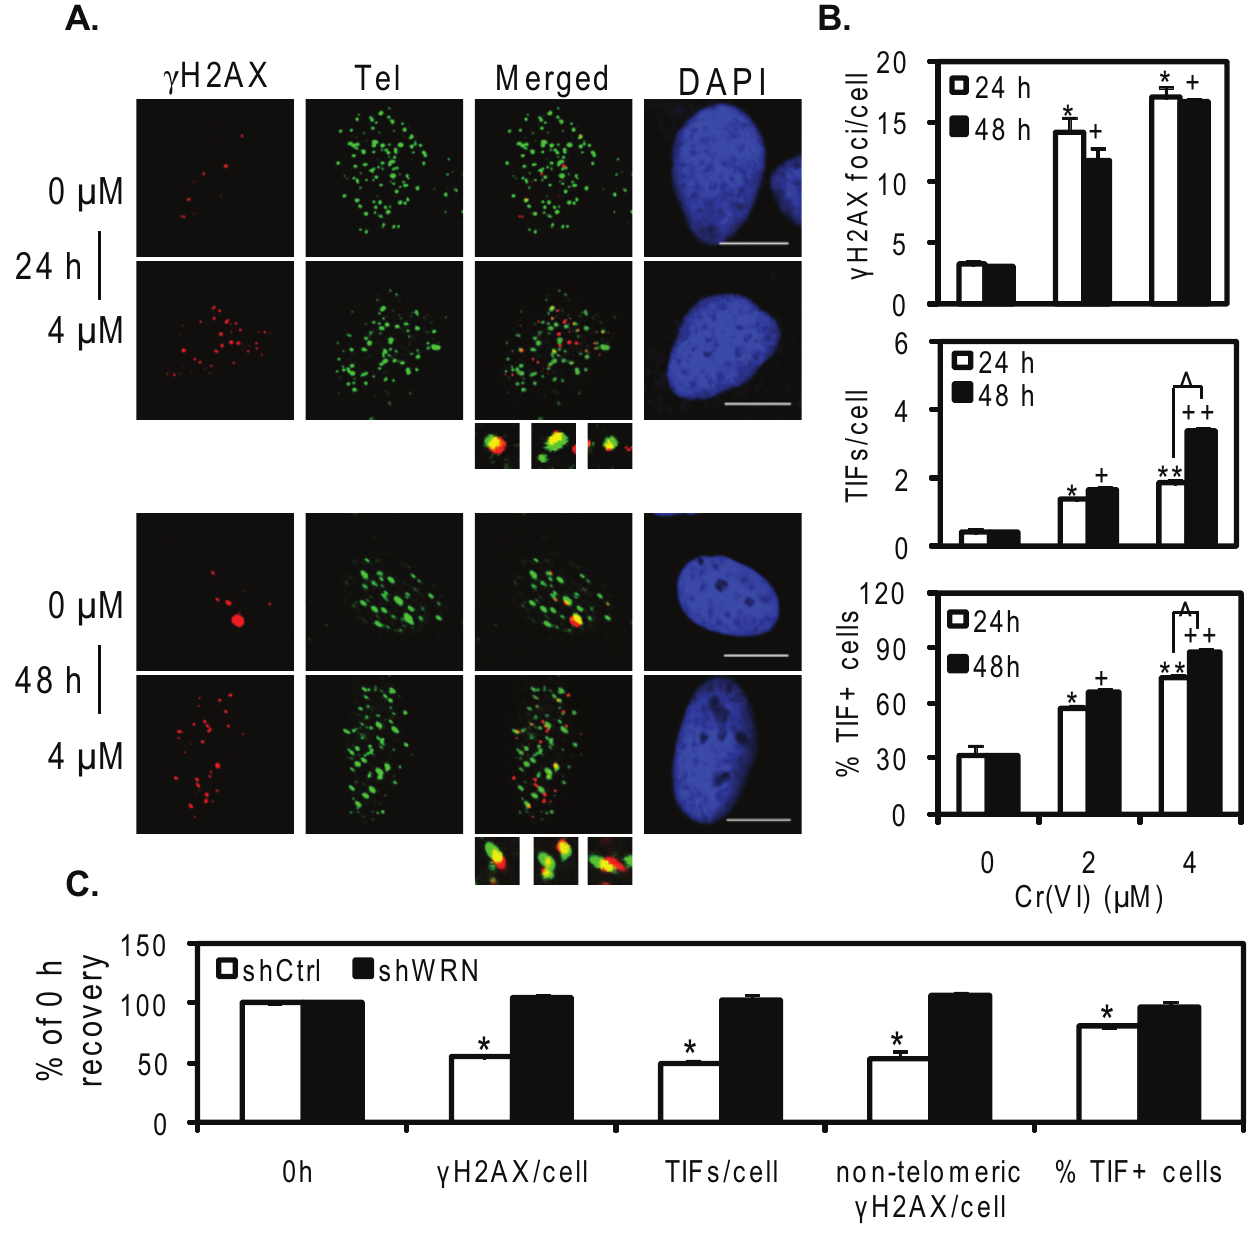
Figure 5. WRN deficiency delays recovery from Cr(VI)-induced telomere damage. (A) Confocal images of EYFP-WRN U2OS cells exposed to the indicated Cr(VI) concentrations for 24 or 48 h. Cells were subjected to IF-FISH analysis of c H2AX (red) and telomere (green) colocalization (yellow). (B) Average c H2AX foci and TIF number per cell and the percent of TIF positive cells. Bars with a different number of symbols are significantly different from each other within each treatment time point (p , 0.05). (C) Recovery kinetics of DNA damage and TIFs following Cr(VI) treatment. Cells were exposed to 4 m M Cr(VI) for 48 h and then cultured in Cr(VI)-free medium for 12 h. The values at 12 h recovery were expressed as percent of the values at 0 hr recovery (immediately after the 48 h Cr(VI) treatment). The average number of c H2AX foci, TIFs and non-telomeric c H2AX foci per cell was calculated along with the percent of TIF positive cells. The data represent mean 6 SE from two independent experiments, based on at least 50 randomly chosen cells for each Cr(VI) treatment. Symbol(s) above a bar indicates significantly different from the values at 4 m M Cr(VI) treatment for 48 h (p , 0.05). doi:10.1371/journal.pone.0011152.g005 observed several types of telomeric defects [39] (Figure 6A, Figure (ALT) pathway to maintain telomere status [38]. Importantly, WRN depletion in U2OS cells does not impair proliferation [37], S2), and compared exposed to unexposed cells (* = significant but does increase sensitivity to Cr(VI) toxicity (Figure 4). difference) within the same cell line, as well as exposed shWRN to exposed shCtrl cells ( # = significant difference). After Cr(VI) To directly test Cr(VI)-induced telomeric defects in WRN exposure the incidence of telomere loss (signal-free ends, SFEs) depleted cells, compared to WRN proficient cells, the shWRN and increased in both shCtrl and shWRN cells, compared to untreated shCtrl U2OS cell lines were exposed to 3 m M Cr(VI) for 48 h and recovered in Cr(VI)-free media with colcemid for 10 h. We cells, but the levels of SFEs was significantly higher in shWRN cells